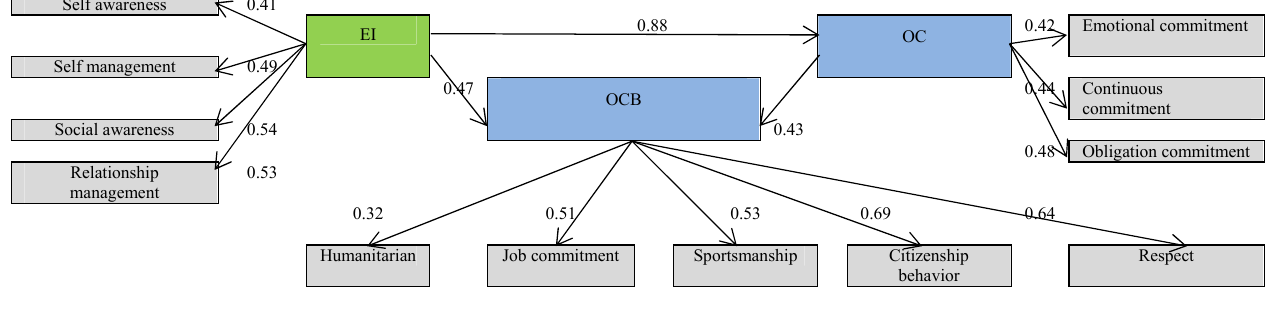
Fig. 2. The results of standard coefficients